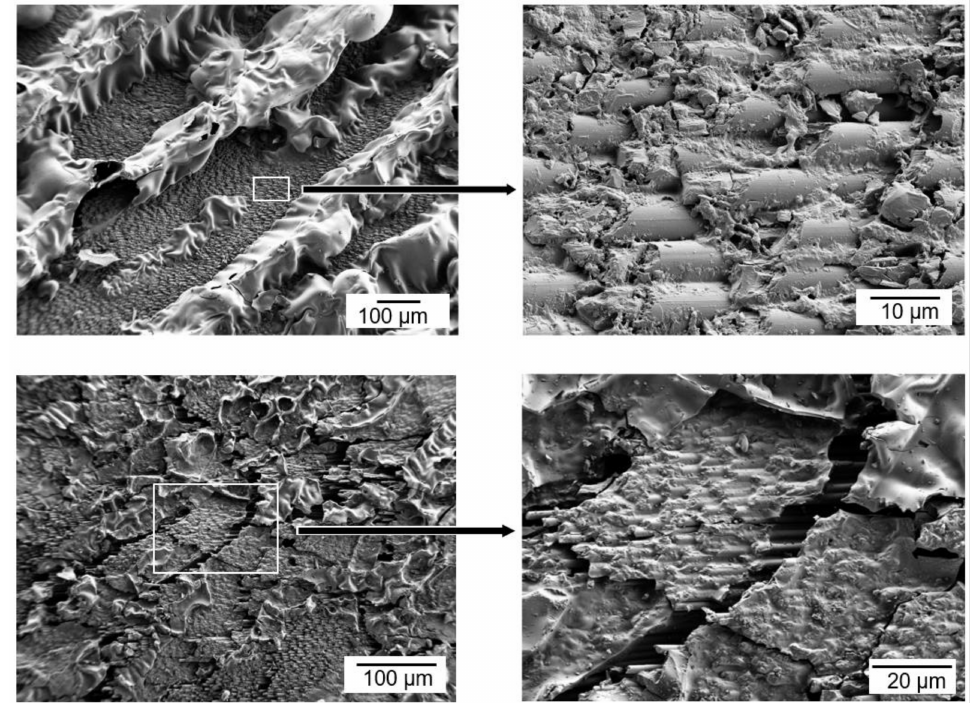
Figure 15. SEM photographs of the surface of a sample with an out-of-plane fibre angle of 15 ◦ after 60 s of hot-air